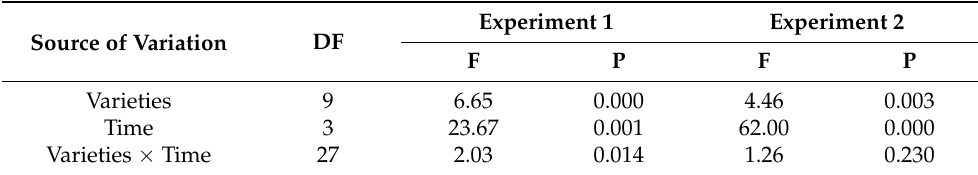
Table 5. Effect of variety, time and interaction on the incidence of bacterial wilt on amaranth plants before cutting in the